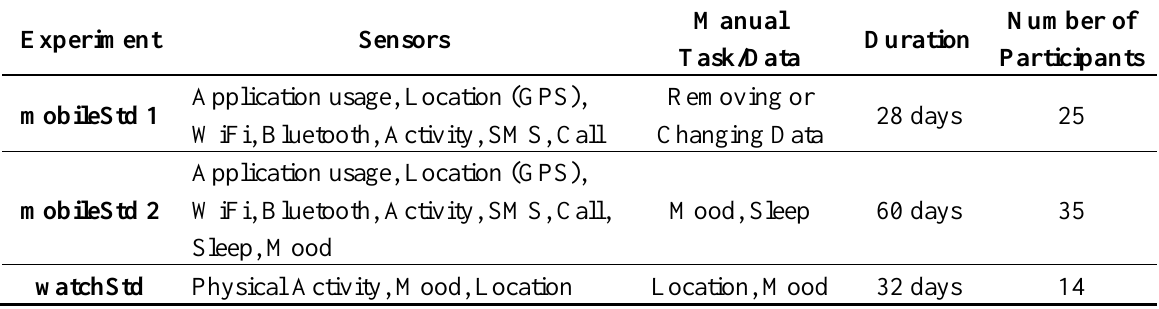
Table 1. Overview of the studies and their